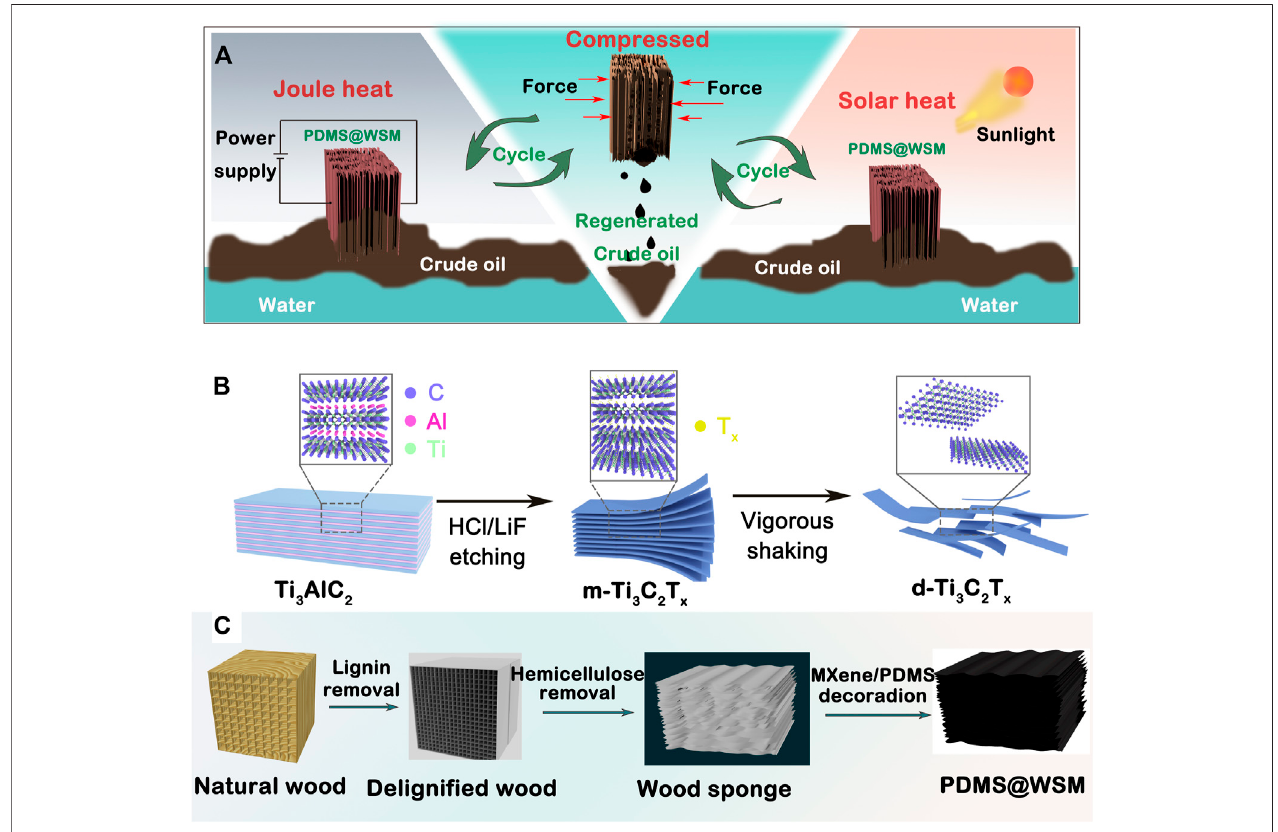
FIGURE6|(A) SchematicillustrationofJoule-heatingandsolar-heatingPDMS@WSMtocleanupandrecoveraviscouscrudeoilspill. (B) Schematicshowingthe synthesis process of the MXene nanosheet. (C) Schematic illustration of the fabrication of the wood sponge and PDMS@WSM (Wang et al., 2022).